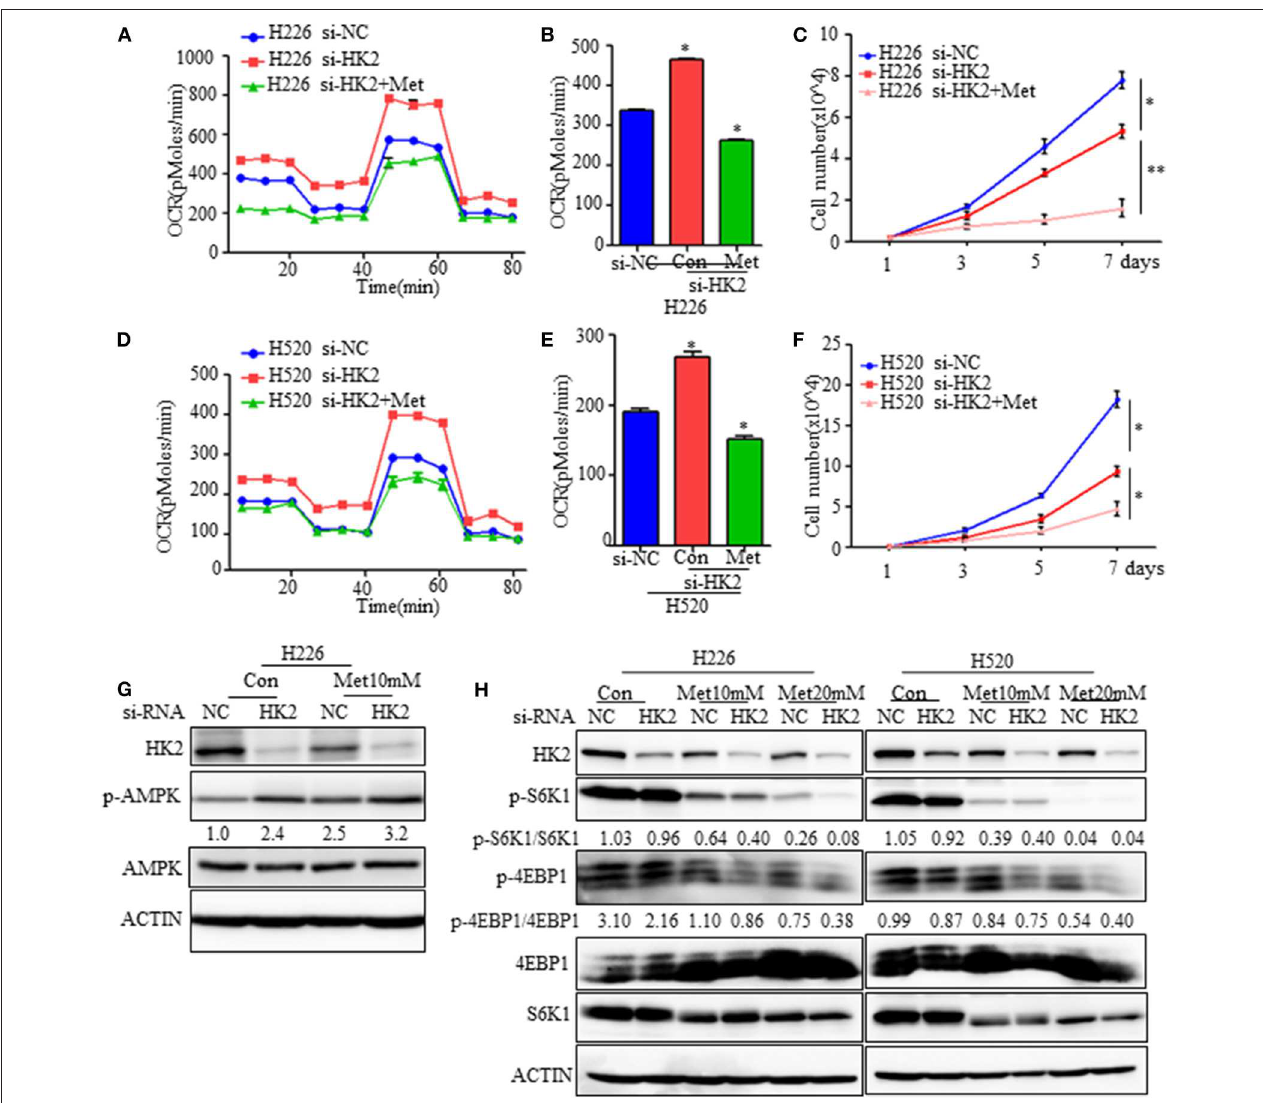
FIGURE 5 | Effect of HK2silencing and metformin treatment on mTORC1 activity. (A,B) Seahorse metabolic analysis of oxygen consumption rates (OCRs) in H226 si-NC- and siHK226-transfected cells with or without metformin treatment (10mM). (C) Cell number representing the proliferation of H226 siNC- and siHK2-transfected cells with or without metformin treatment (10mM). (D,E) Seahorse metabolic analysis of oxygen consumption rates (OCRs) in H520 si-NC- and siHK2-transfected cells with or without metformin treatment (10mM). (F) Cell number representing the proliferation of H520 siNC- and siHK2-transfected cells with or without metformin treatment (10mM). (G) Immunoblot showing the expression of phospho-AMPK. (H) Immunoblot showing the expression of phosphor-S6K1 and phosphor-4EBP1 in H226/H520 siNC- and siHK2-transfected cells with or without treatment with different doses of metformin. * p < 0.05, ** p <